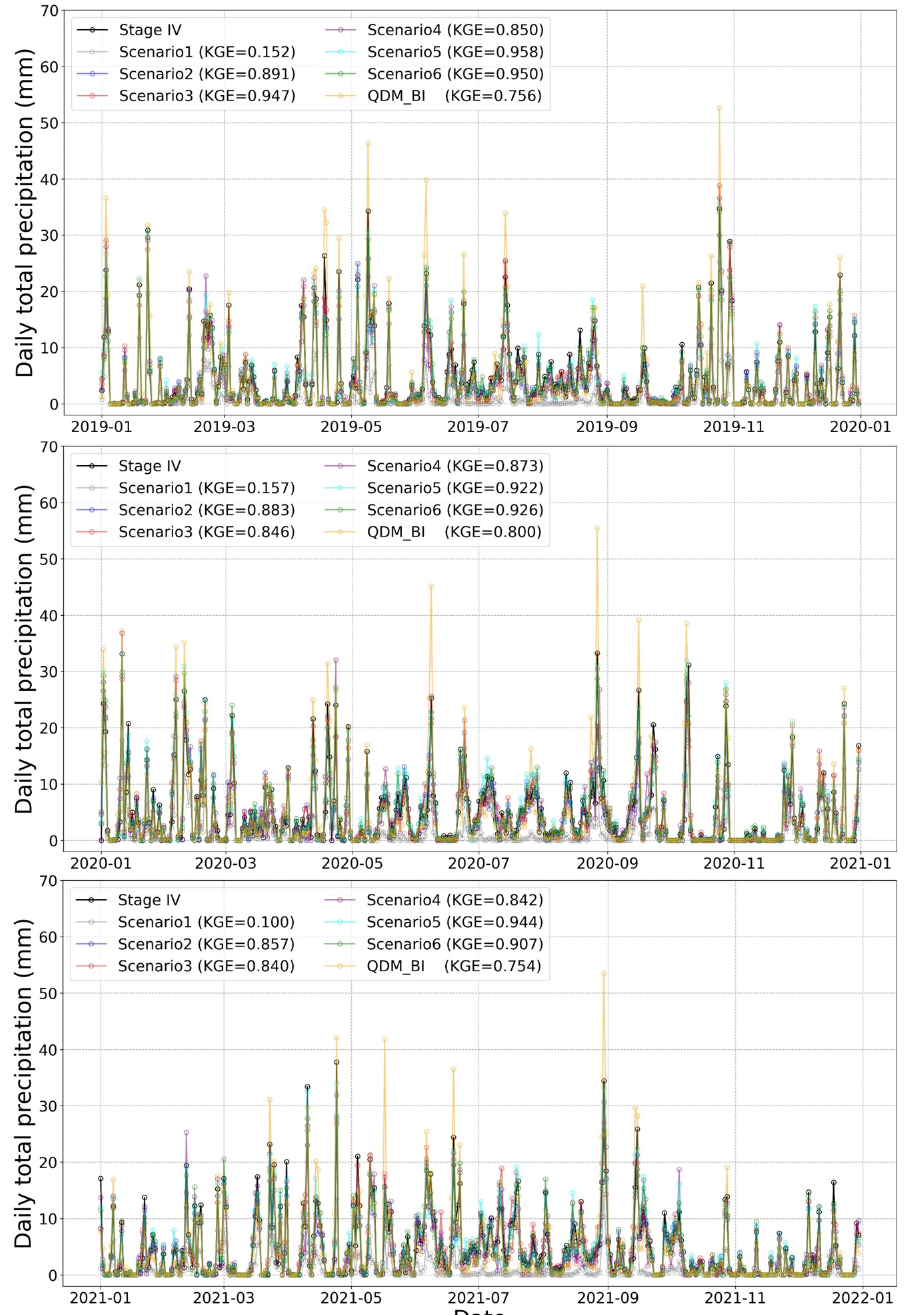
Figure 5. Daily total precipitation during the testing period (2019–2021) from Stage IV, QDM_BI, and the 6 DL experimental runs